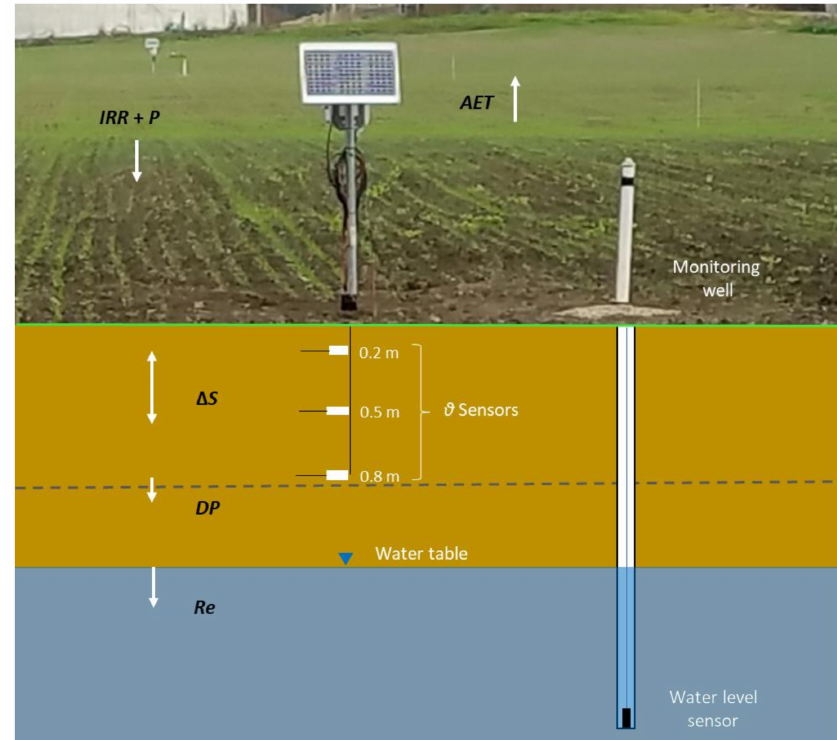
Figure 2. Schematic illustrating soil water ( θ ) and groundwater-levels measurement at each monitor- ing station. The main water budget components–irrigation ( IRR ), precipitation ( P ), change in soil water ( ∆ S ), deep percolation ( DP ), actual evapotranspiration ( AET ), and aquifer recharge ( Re )–are shown. Figure not to